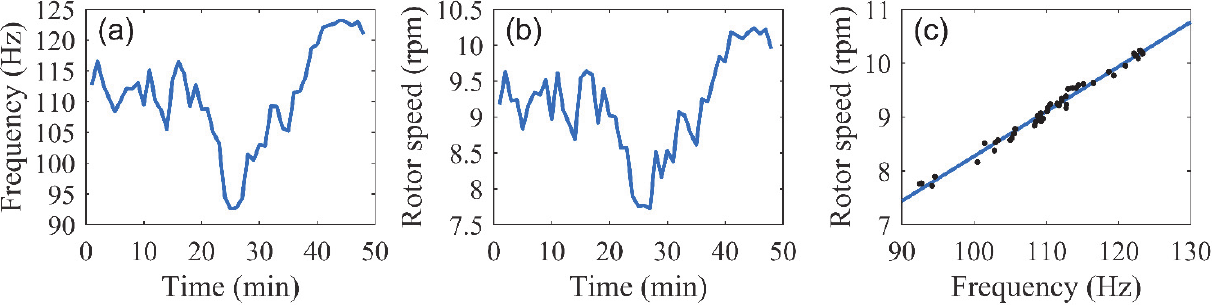
Figure 10. Comparison of the extracted dominant frequencies and the wind turbine rotor speed in the air during the same time period: ( a ) extracted dominant frequencies of the operational signal; ( b ) wind turbine rotor speed in the air; ( c ) linear fitting results.